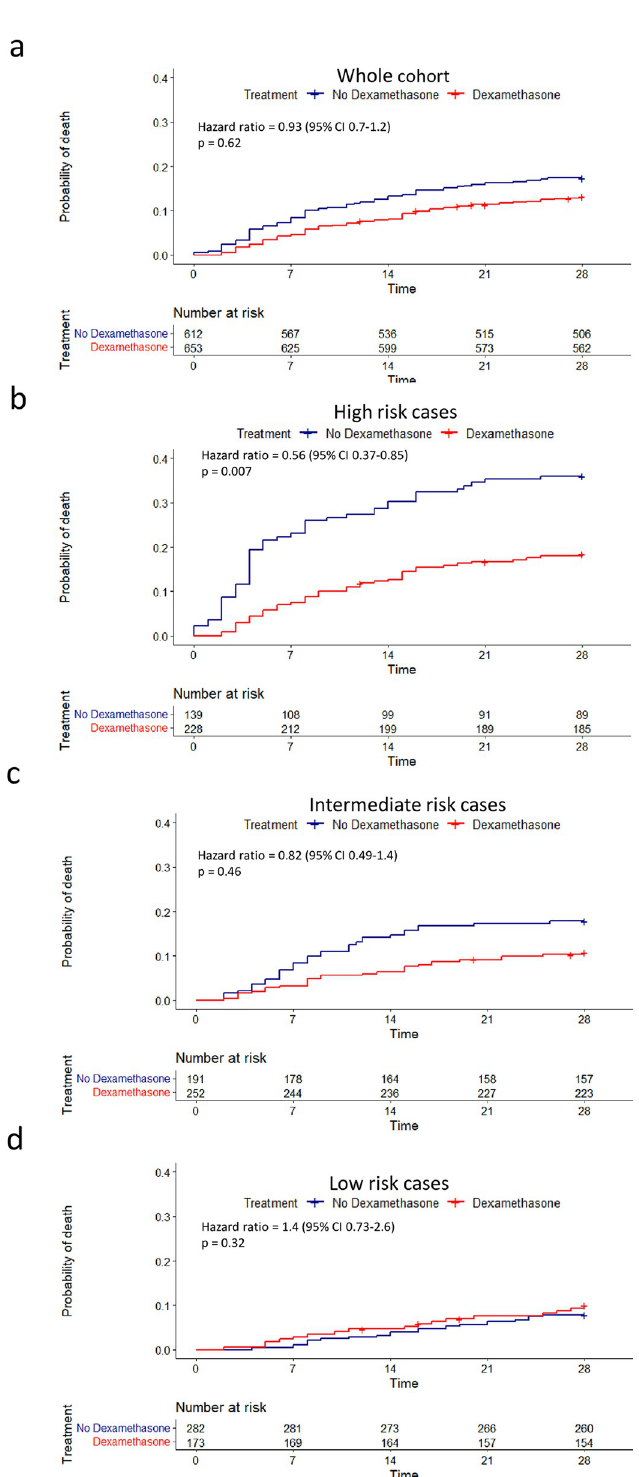
Fig 3. Effect of dexamethasone on mortality at day 28. (a) Kaplan–Meier survival curves for 28-day mortality among the whole cohort in those who were treated with dexamethasone (red line) vs untreated cases (blue line). (b-d) Kaplan– Meier survival curves for those treated with dexamethasone (red lines) vs untreated (blue lines) in HI5-NEWS2 high risk (b), intermediate risk (c) or low risk (d) groups. All quoted hazard ratios are adjusted for age. At risk data are listed beneath plots. Time measured in days. Cases censored before 28 days indicated by